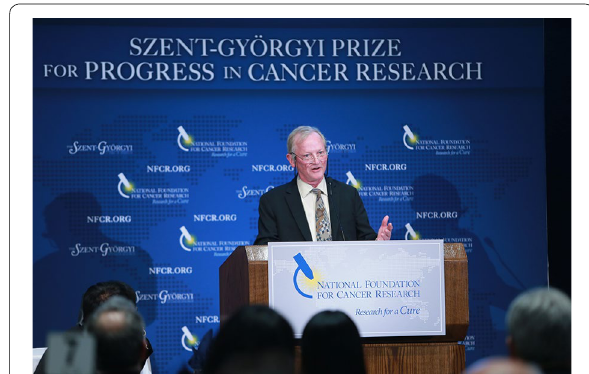
Fig. 2 Dr. Frederick Alt, winner of the 2015 Szent-Györgyi Prize, gave an acceptance speech at the Award Ceremony held on April 29, 2015 in Washington